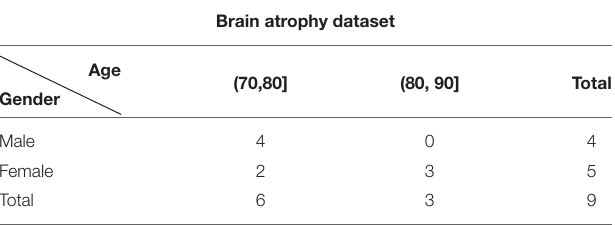
TABLE 2 | The age and gender distribution of the brain atrophy dataset. Brain atrophy